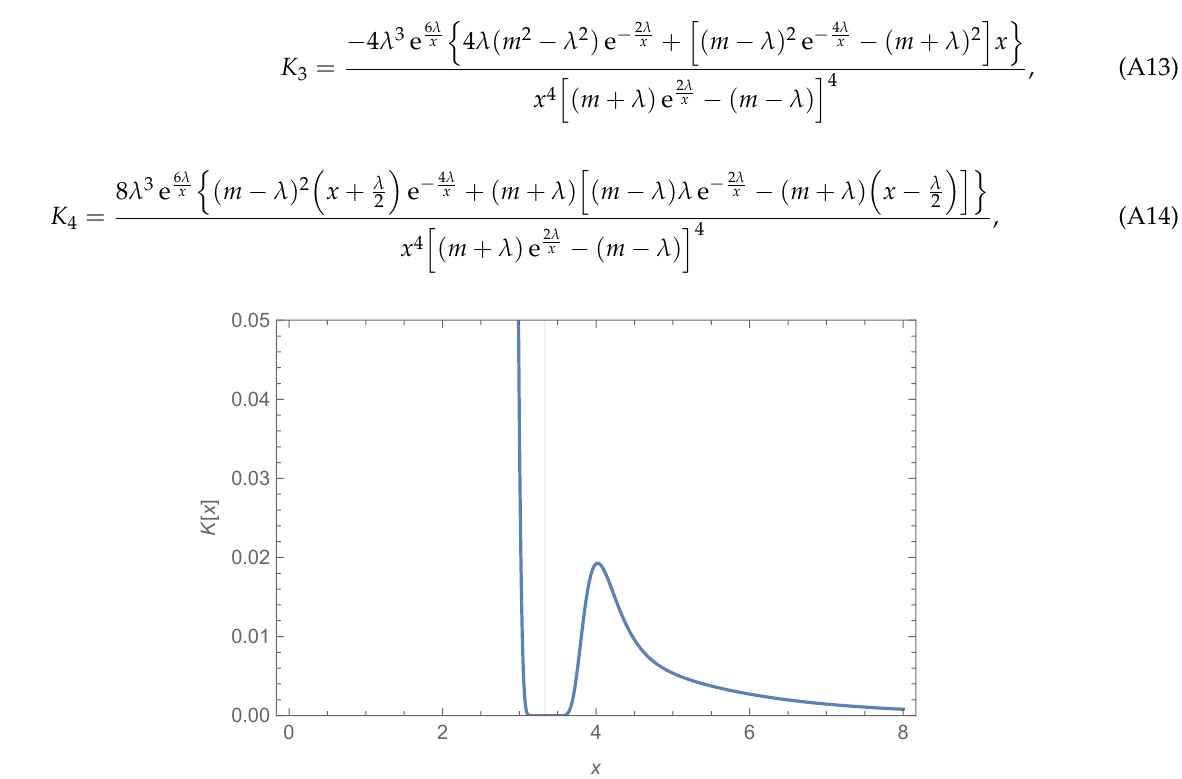
Figure A2. Plot of the Kretschmann scalar for the second solution Equation (76), where the vertical lines indicate the horizons. The value of the parameters are the same as in Figure 3.